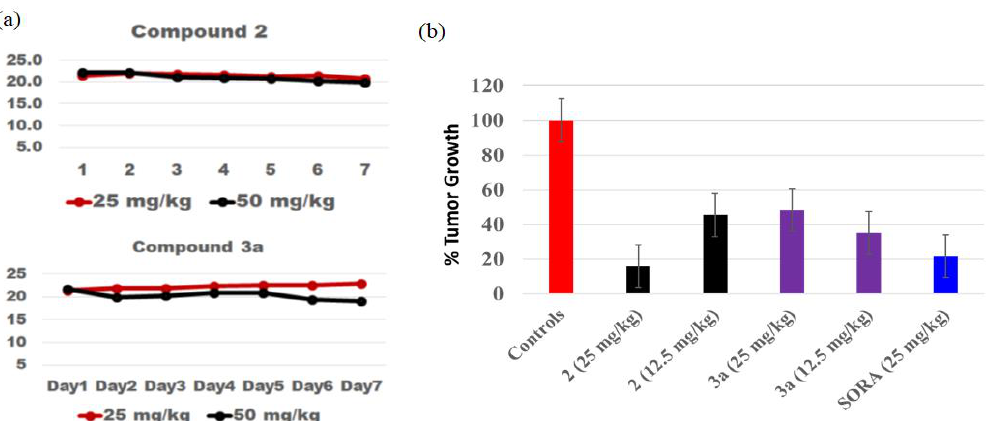
Figure 7. In vivo e ffi cacy of compounds 2 and 3a . ( a ) E ff ects of 2 and 3a on animal weights at the stated doses. ( b ) Compounds 2 and 3a , as standalone agents, robustly suppressed tumor growth in a murine orthotopic model of Hep-G2-Red-FLuc. Error bars represent 10 mice per cohort with the exception of the control experiments, which had 22 mice in total. Data are representative of two di ff erent experiments. p values: controls vs. 2 (12.5 mg / kg) = 0.0625 controls vs. 2 (25 mg / kg) = 0.0043; controls vs. 3a (12.5 mg / kg) = 0.0264; controls vs. 3a (25 mg / kg) = 0.0888 and controls vs. SORA =